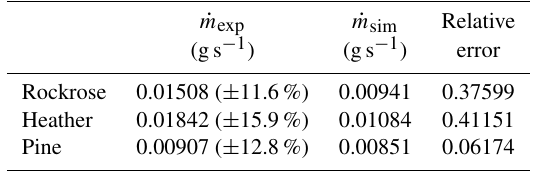
Table 4. Mass-loss rates of each species.